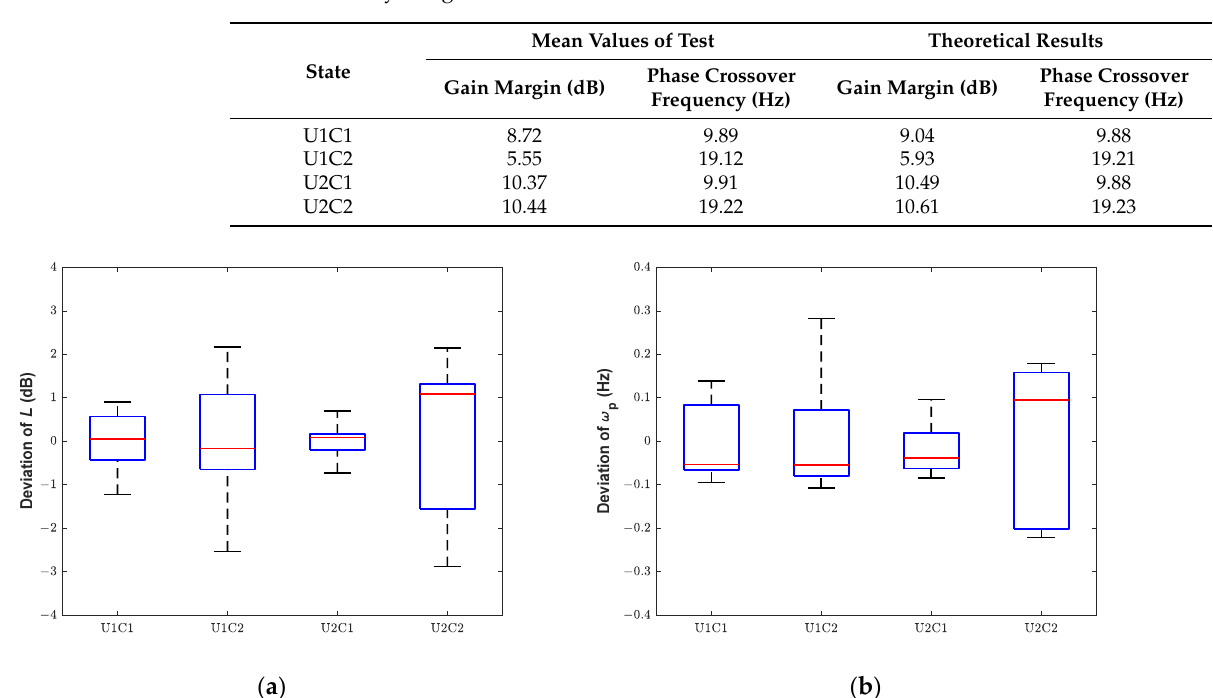
Table 2. Stability margin of the slender vehicle at Ma = 1.5.